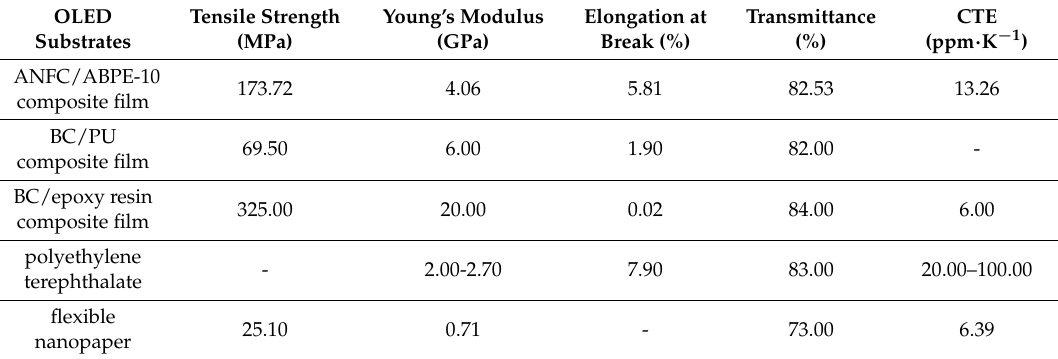
Table 3. Performance comparison of different polymers as flexible Organic light-emitting diodes (FOLED) substrates